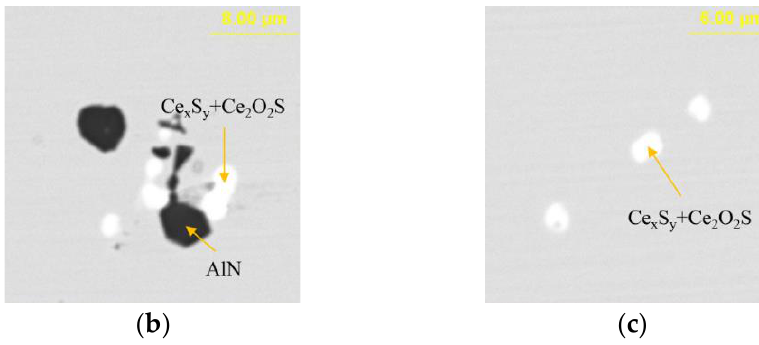
Figure 12. Typical morphology and energy spectrum of inclusions in the steel with 95 ppm Ce content. ( a )